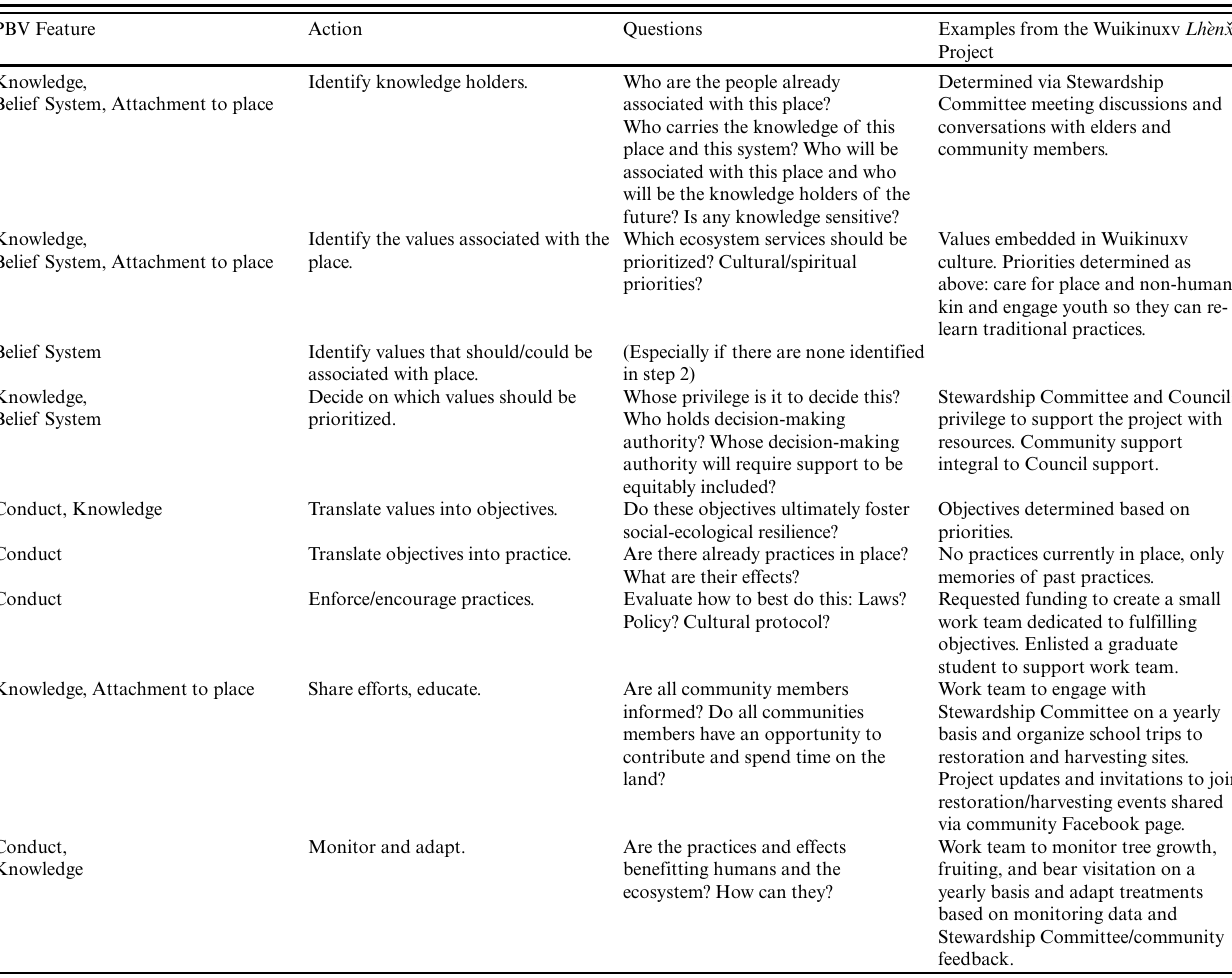
Table 1. Proposed Framework for initiating a place-based values (PBV) approach into restoration planning and implementation. Inspired by Table 2 in Artelle et al. 2018. This framework was built for people considering how to implement place-based values in restoration and to clarify how actions relate to the features of place-based